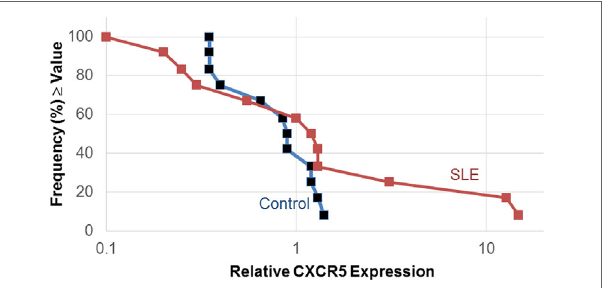
FigUre 1 | Estradiol effects on CXCR5 expression in activated systemic lupus erythematosus (SLE) T cells. Human T cells were isolated as described in the text and cultured in serum-free medium without and with estradiol. The relative amount of CXCR5 expression following activation was measured by real-time PCR. Data shown are the frequency of T cell samples from controls ( n = 12) and SLE patients ( n = 12) that exhibited relative CXCR5 expression values that were at or above the value on the x -axis.